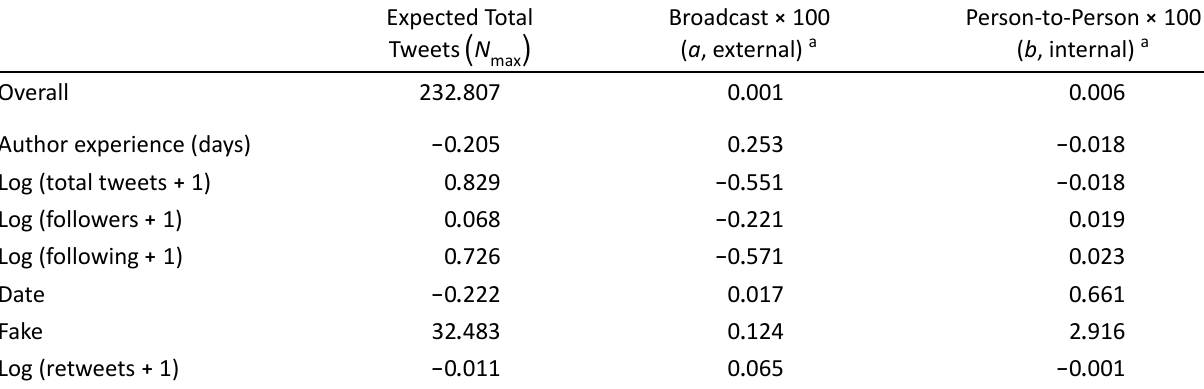
Table 8. Diffusion parameter